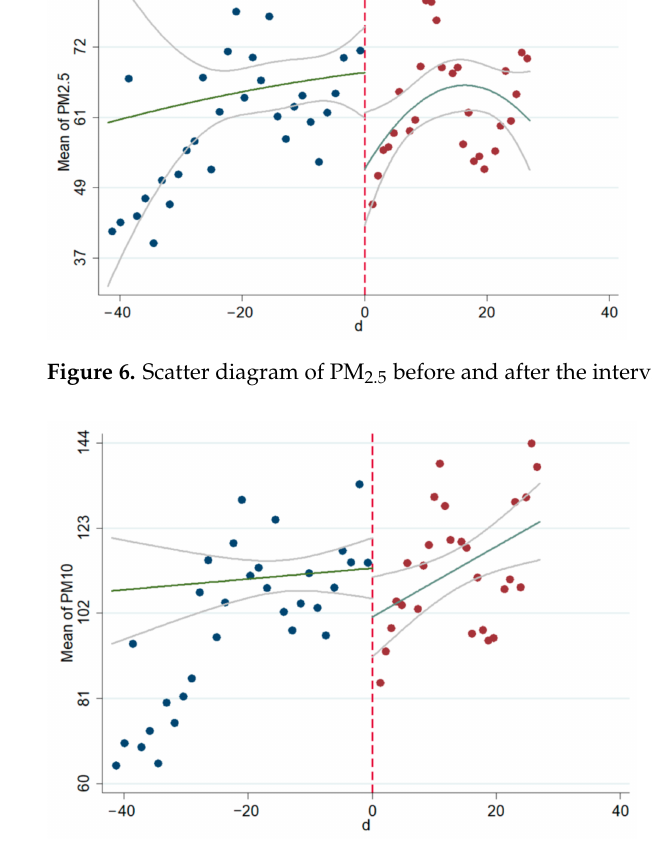
Figure 7. Scatter diagram of PM 10 before and after the interviews (linear).